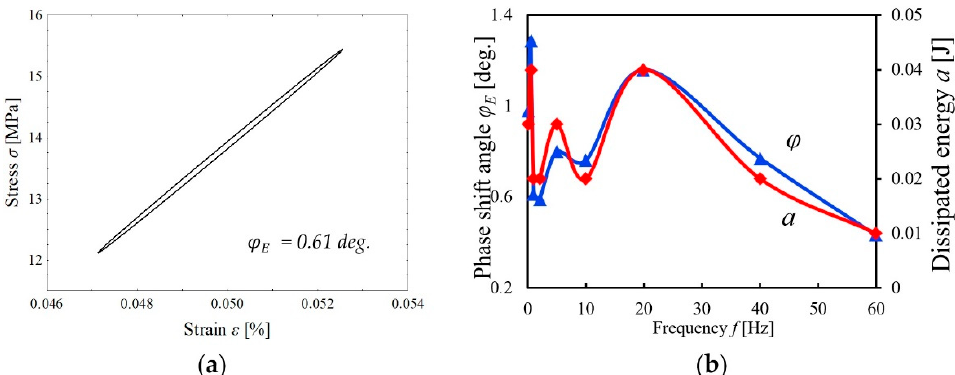
Figure 18. Experimental data obtained during testing the sample 2/46: ( a ) hysteresis loop at a load frequency of 1 Hz (strain